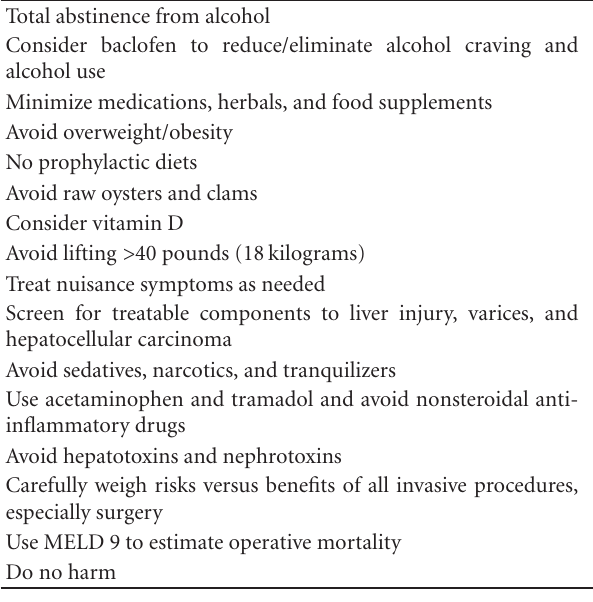
Table 2: General advice regarding the care of patients with cirrho-